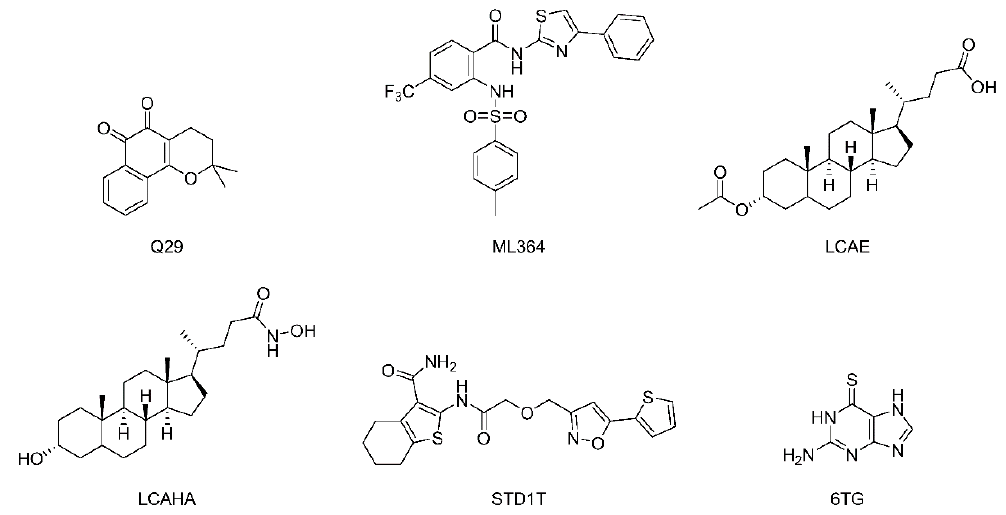
Figure 6. Structures of representative USP2 inhibitors.